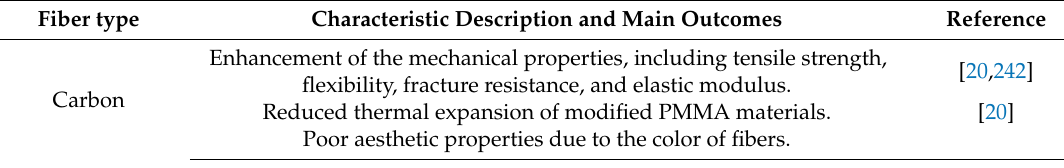
Table 6. Characteristics of various fibers used for the mechanical reinforcement of